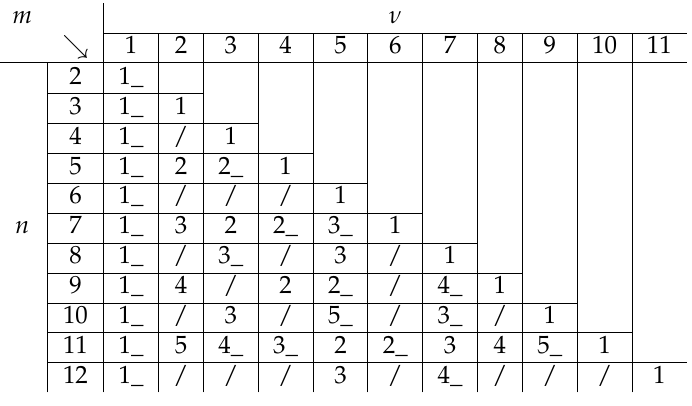
Table 3. Combination of parameters m and ν for 2 ≤ n ≤